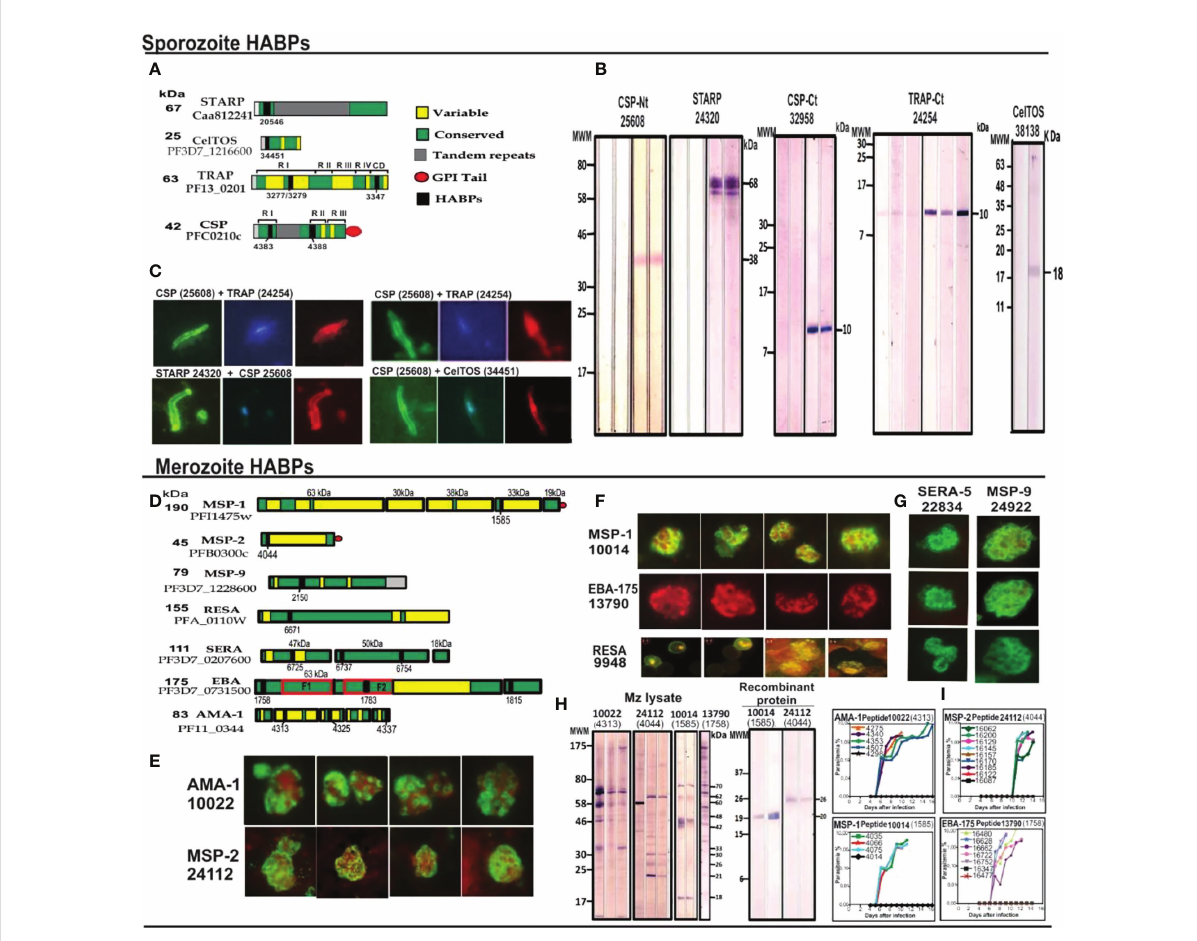
FIGURE 4 cHABP location in proteins and their mHABPs ’ immunogenicity. (A) Diagrammatic representation: bar length represents their appropriate molecular weight (MW). Each cHABP location is indicated by the institute ’ s number code shown below. (B) Western blot (WB) analysis of recombinant fragments produced in our Institute covering different protein regions (the STARP recombinant fragment was kindly provided by Prof. Pierre Druille, Pasteur Institute, Paris, France). (C) Immuno fl uorescence patterns regarding sera from immunised Aotus monkeys, showing reactivity with CSP-1 and STARP (green fl uorescence) on Spz membrane and TRAP and CelTOS intracytoplasmic location (red fl uorescence). (D) Diagrammatic location of P. falciparum proteins involved in RBC invasion. (E – G) IFA patterns for P. falciparum Mrz, showing reactivity with membrane proteins MSP1, MSP2, MSP9, rhoptry proteins EBA-175, AMA-1, SERA and infected erythrocyte (iE) membrane (RESA). (H) Immuno fl uorescence patterns regarding sera from immunised Aotus monkeys, showing reactivity with AMA-1, MSP-1, MSP-2 and EBA-15 (green fl uorescence) on Mrz membrane intracytoplasmic location (red fl uorescence). (I) The course of parasitemia in Aotus monkeys immunized with fully protection inducing peptides. Adapted from Ref. 16,